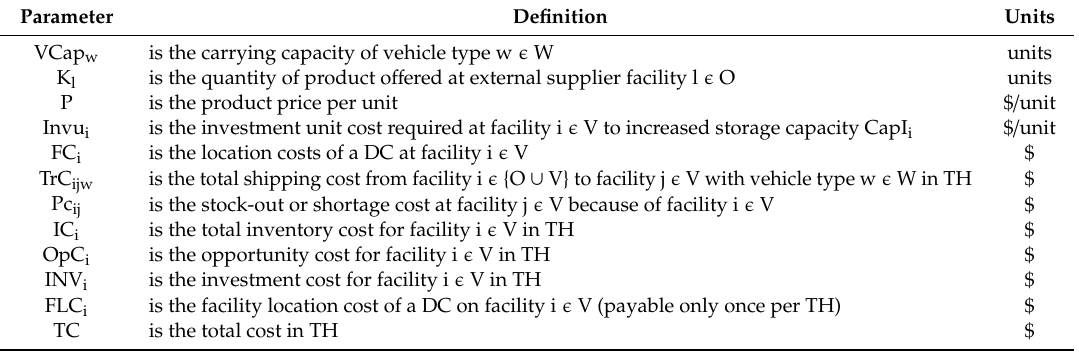
Table 4. CLITraP-HTF